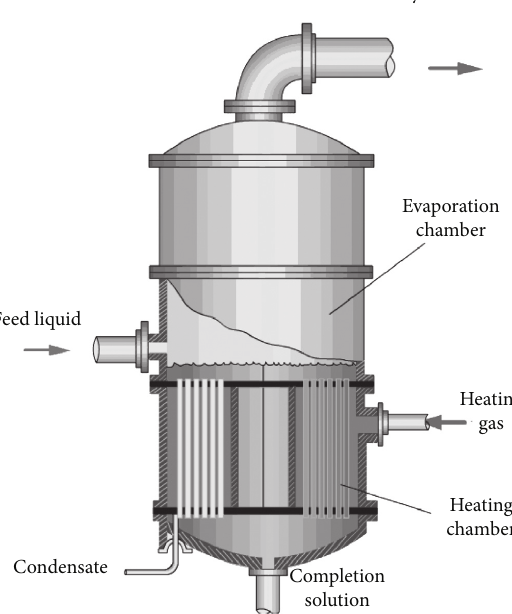
Figure 1: Design of the vacuum